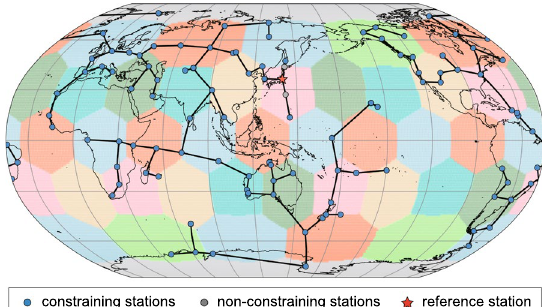
Fig. 2 Distribution of stations used for F5 RSA in 2020 with a geodesic dome. The black lines indicate the baselines formed by the “SHORTEST” strategy in the Bernese